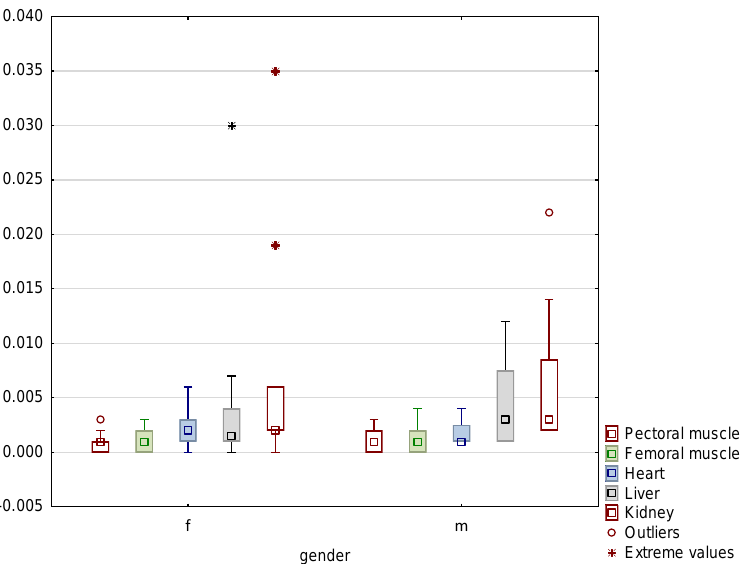
Figure 1. Box-and-whisker plot showing the median values for the mercury concentrations of the organs tested in common woodpigeons of both genders. Box shows 25 – 75% coefficient, whiskers show minimum and maximum range of non-outliers.